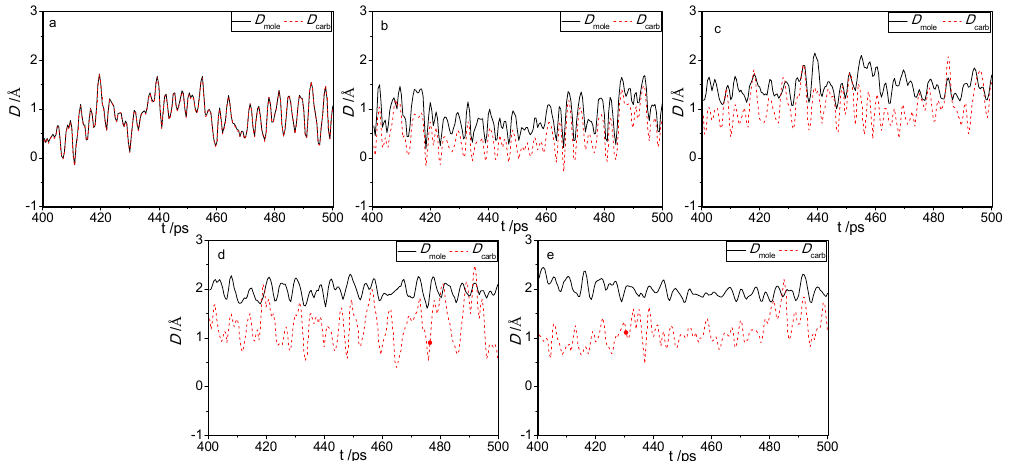
Figure 3. The distance of the five acid molecules ( D mole ) and their carboxyl groups ( D carb ) from the surface as a function of simulation time. ( a ) Formic acid; ( b ) Acetic acid; ( c ) Levulinic acid; ( d ) Naphtenic acid; ( e ) Stearic acid.